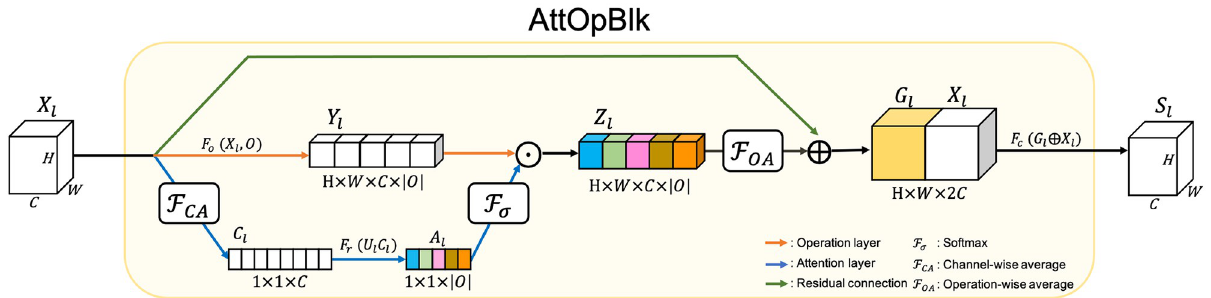
Fig 4. Structure of AttOpBlk. The attention vector A l learned using the channel-wise average of the input feature map is multiplied with Y l , the result of applying the operations in the operation set on the input feature map. The attention layer can learn the optimal operation according to the degradation characteristics of the input feature